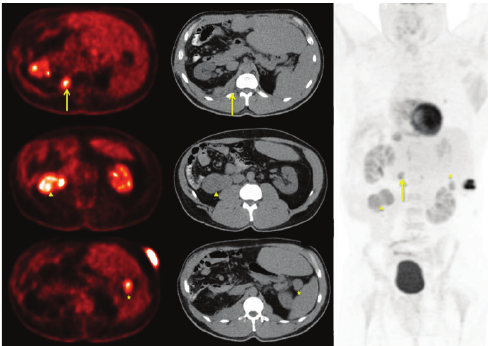
Figure 3: Abdomen and pelvis CT that shows a 16 cm mass in the right lobe of the liver, with mass effect on the surrounding tissues, with compression of the IVC.